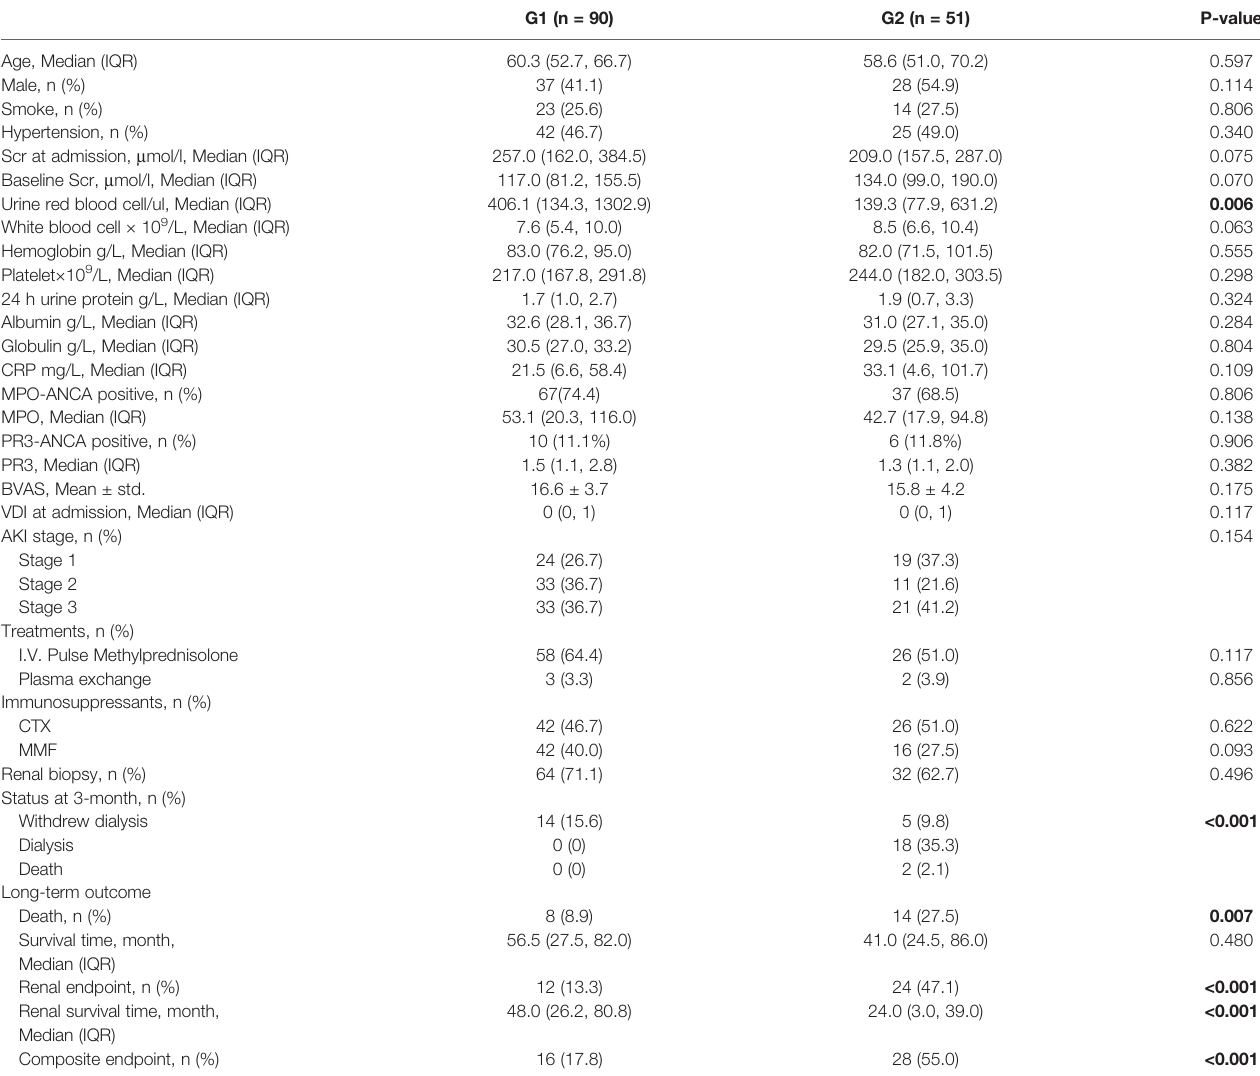
TABLE 3 | Clinical and laboratory data of AAV patients in G1 and G2 subgroups.